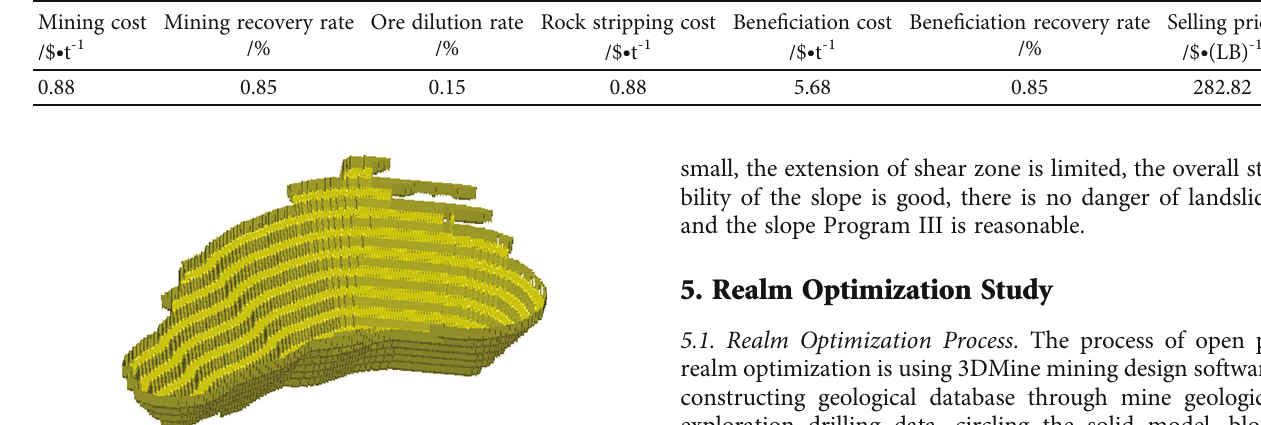
Table 7: Block model geometry parameters.